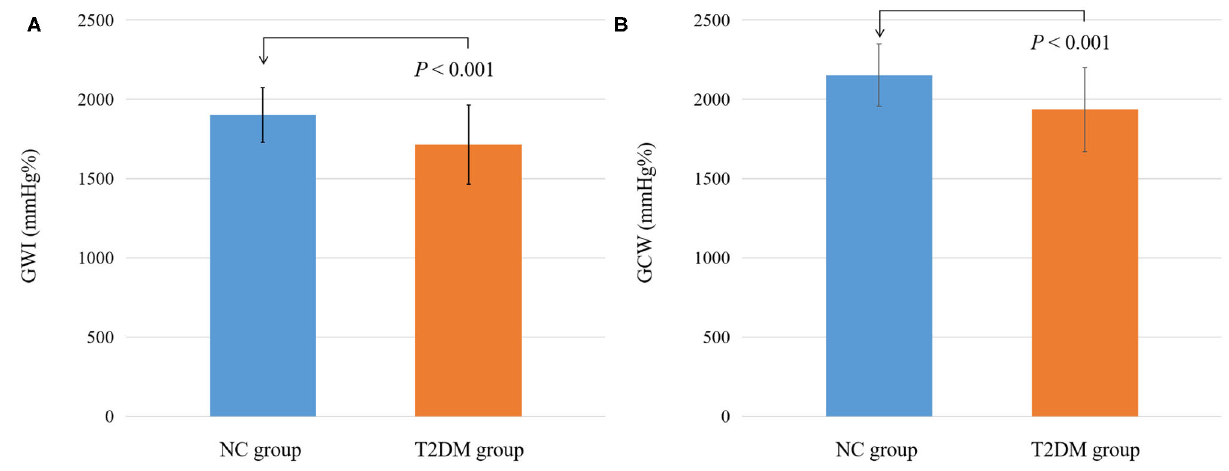
FIGURE 3 | Differential changes of myocardial work parameters between NC and T2DM groups. (A) Differential changes of GWI between NC and T2DM groups. (B) Differential changes of GCW between NC and T2DM groups.T2DM, type 2 diabetes mellitus; NC, normal control; GWI, global work index; GCW, global constructive